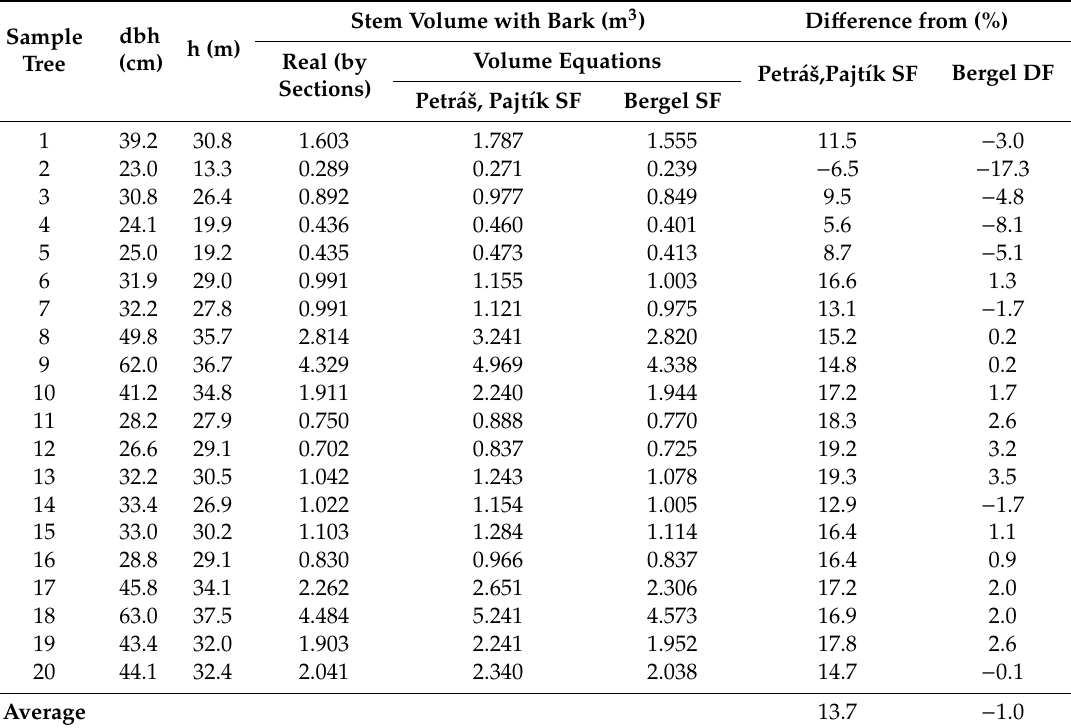
Table 1. Comparison of methods of Douglas fir volume calculation on felled sample